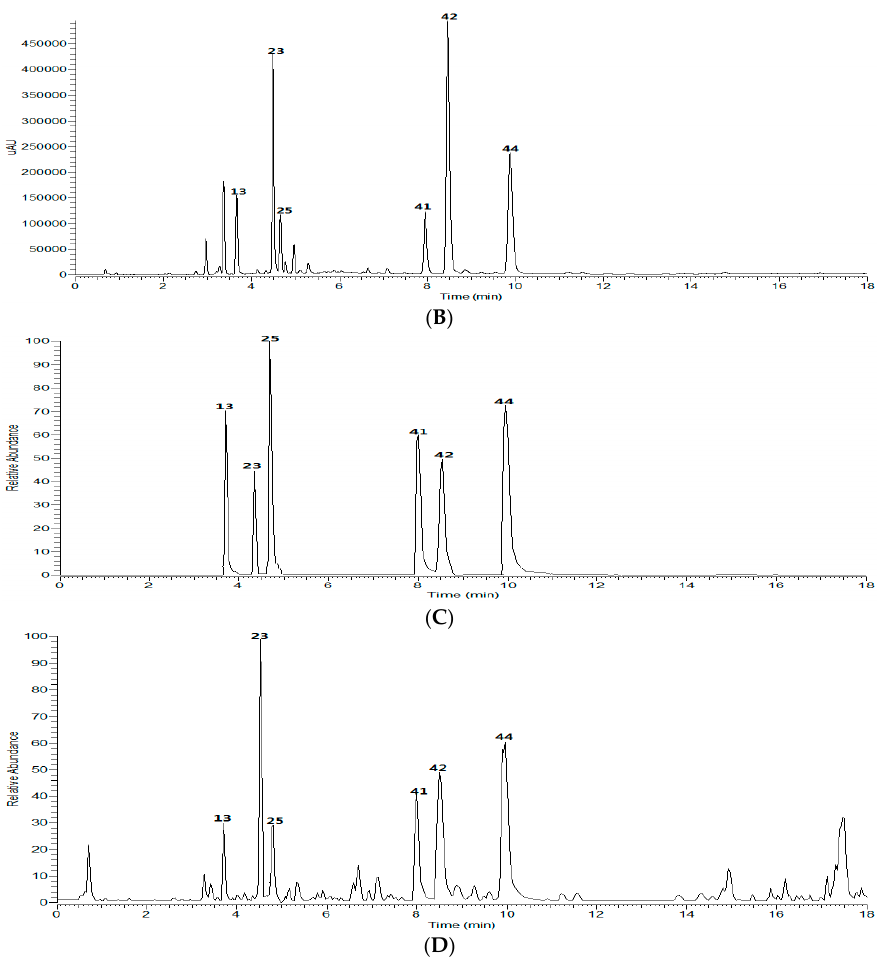
Figure 1. UHPLC-DAD-LTQ-Orbitrap analysis of CGAs in Kuding tea (2 μ L): UHPLC-DAD chromatogram of reference standards ( A ) and the extract ( B ) at 327 nm; the total ion chromatogram (TIC) of reference standards ( C ) and the extract ( D ) in negative mode.